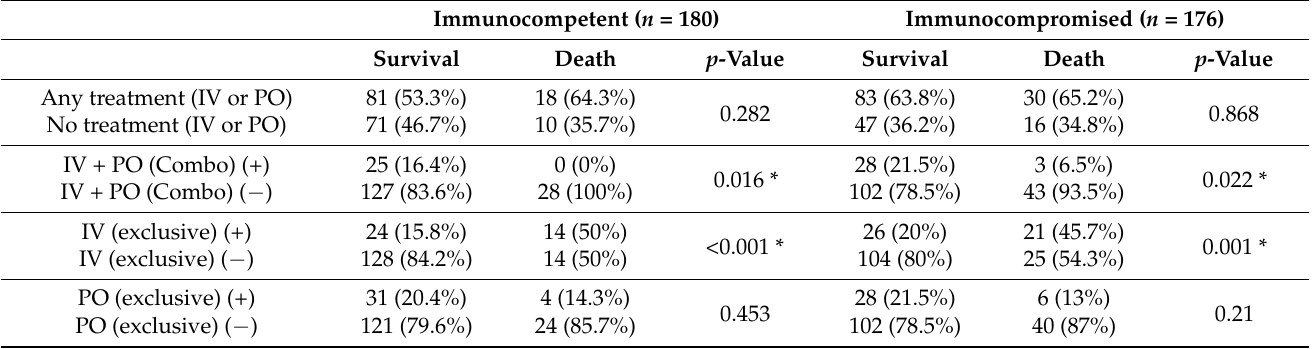
Figure 3. Kaplan–Meier survival curve analysis of patients with CMV GI diseases. ( A ) Patients with different infected locations had no statistical difference in in-hospital mortality rates (log-rank p = 0.806). ( B ) Patients with immunocompromised status had significantly worse survival outcomes than those with immunocompetent status (log-rank p = 0.017). ( C ) Patients receiving Combo therapy had significantly better survival outcomes than others (log-rank p = 0.002). ( D ) Patients with different immune status and treatment courses had significantly different survival outcomes (log-rank p = 0.001). CMV, cytomegalovirus; CO, colon; Combo, combination of intravenous and oral antiviral therapy; ES, esophagus; GI, gastrointestinal; SI, small intestine; ST, stomach. Table 3. The impact of different antiviral treatment courses and immune status on in-hospital mortality in CMV GI diseases.